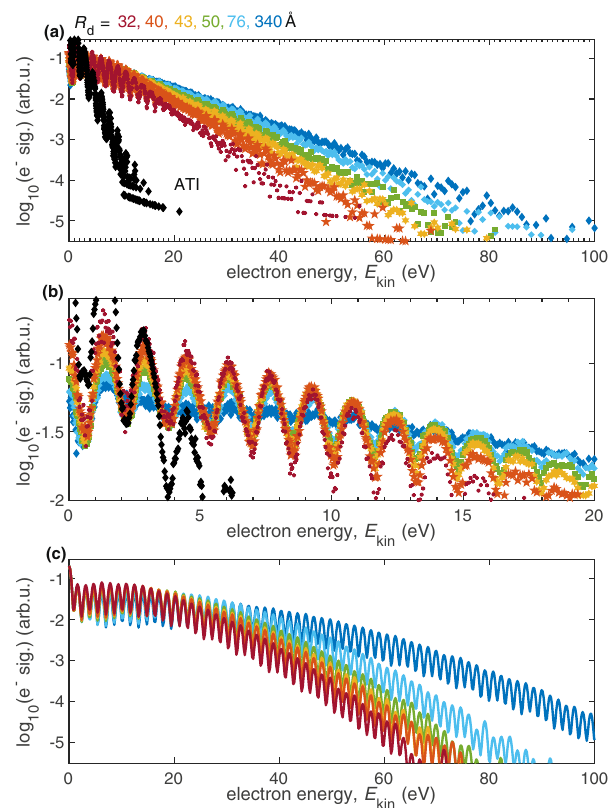
Fig. 2 Dependence of LAES spectra on the droplet size, for droplet radii between R d = 32 Å and R d = 340 Å ( R d values are calculated from the mean values of the droplet size distributions 30 ). a The experimental spectra are obtained with In atoms at I = 1.1 ⋅ 10 13 Wcm − 2 and show a pronounced increase of the LAES energy gain with He shell thickness. In addition, the gas-phase ATI spectrum is shown for comparison. The abrupt increase of the droplet radius to R d = 340 Å for the lowest droplet source temperature ( T 0 = 10 K) is due to the changing character of the supersonic expansion from sub- to supercritical in this temperature regime 30 . b Close- up of the low-energy region of ( a ). c Simulated LAES spectra for different droplet sizes, under the same conditions as in ( a ). The spectra are area